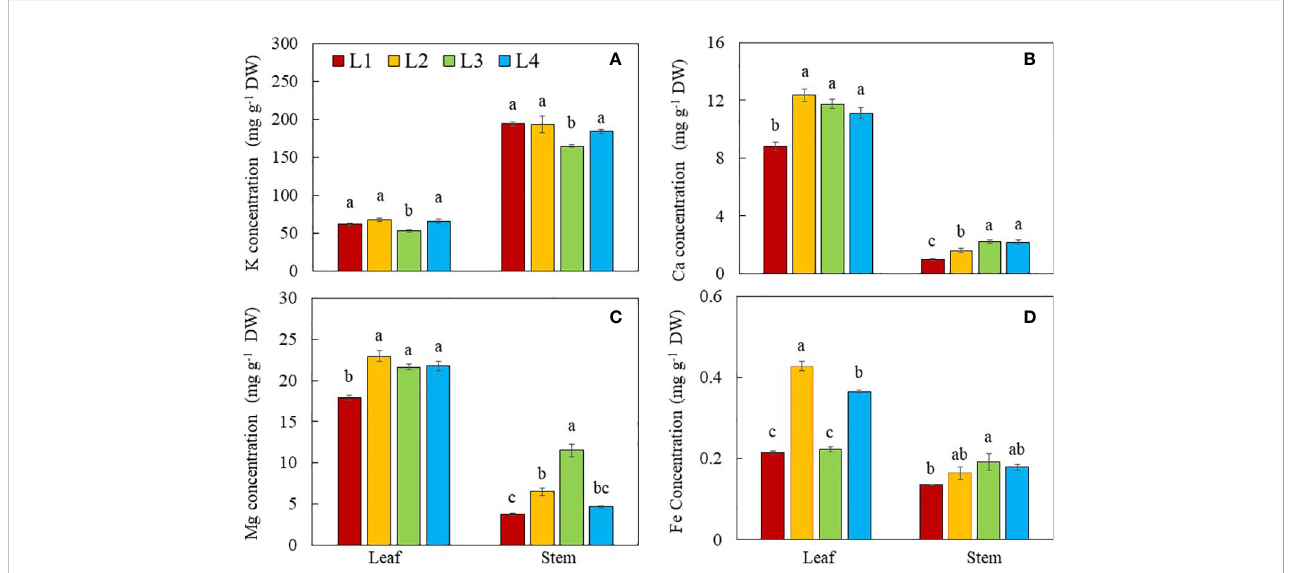
FIGURE 10 Dietary minerals, K (A) , Ca (B) , Mg (C) and Fe (D) concentrations of purslane grown under different light conditions for 14 days. Values are means ± standard errors. Means with different letters are statistically different ( p <0.05; n =4) as determined by Tukey ’ s multiple comparison test for each plant organ. Refer to Figure 1 for the different conditions of L1, L2, L3 and L4.